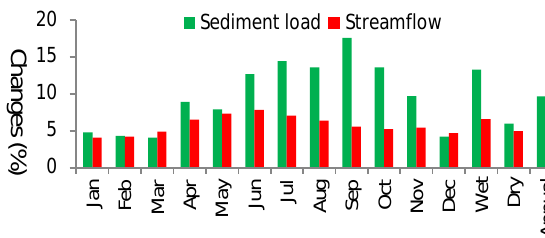
Figure 9. Changes in streamflow and sediment load under land cover changes in 2050 at Laichau